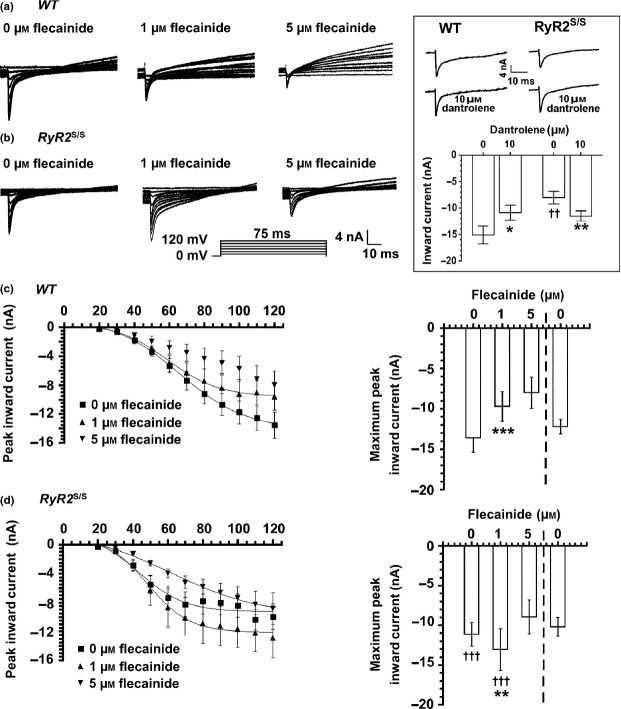
Paradoxical actions of flecainide on INa activation in RyR2S/S and WTatria. Currents in response to depolarizing steps increased in 10 mV increments from 20 to 120 mV in voltage-clamped WT (a, n = 7) and RyR2S/S (b, n = 6) left atria in the presence of 0, 1 and 5 μm flecainide. Currents in response to an 80 mV depolarizing step under control conditions and in the presence of the specific RyR blocker dantrolene (10 μm) are shown in the inset. The current–voltage relationships were fitted to Boltzmann functions for WT (c, left panel) and RyR2S/S (d, left panel) in the presence of 0, 1 and 5 μm flecainide. The right panels in (c) and (d) compare the maximum peak currents before and following withdrawal of flecainide. *denotes significant effects of flecainide or dantrolene. †denotes significant differences between RyR2S/S and WT genotypes at the same flecainide concentration.